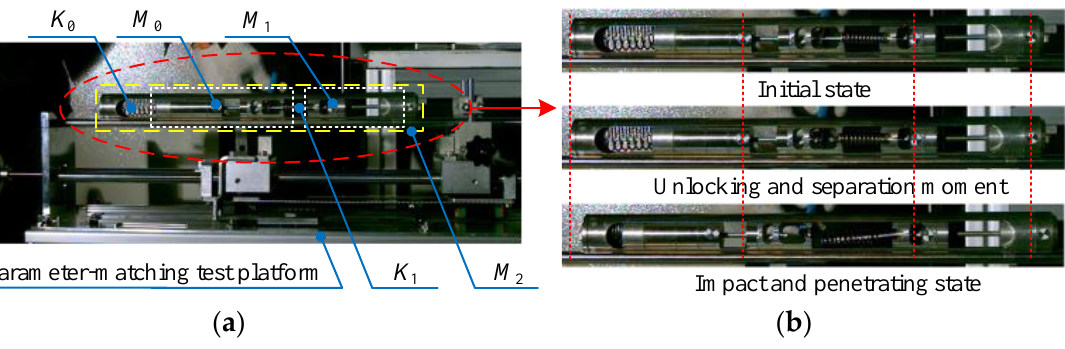
Figure 7. The experimental process: ( a ) the preparatory work for the test; ( b ) experimental process of simulated penetrator.